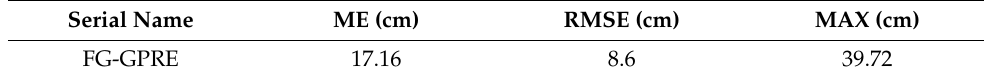
Table 3. Locate the performance profiling list.